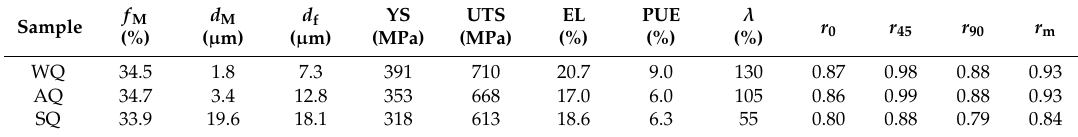
Table 1. Microstructural parameters and mechanical properties of dual-phase (DP) steel specimens. Sample